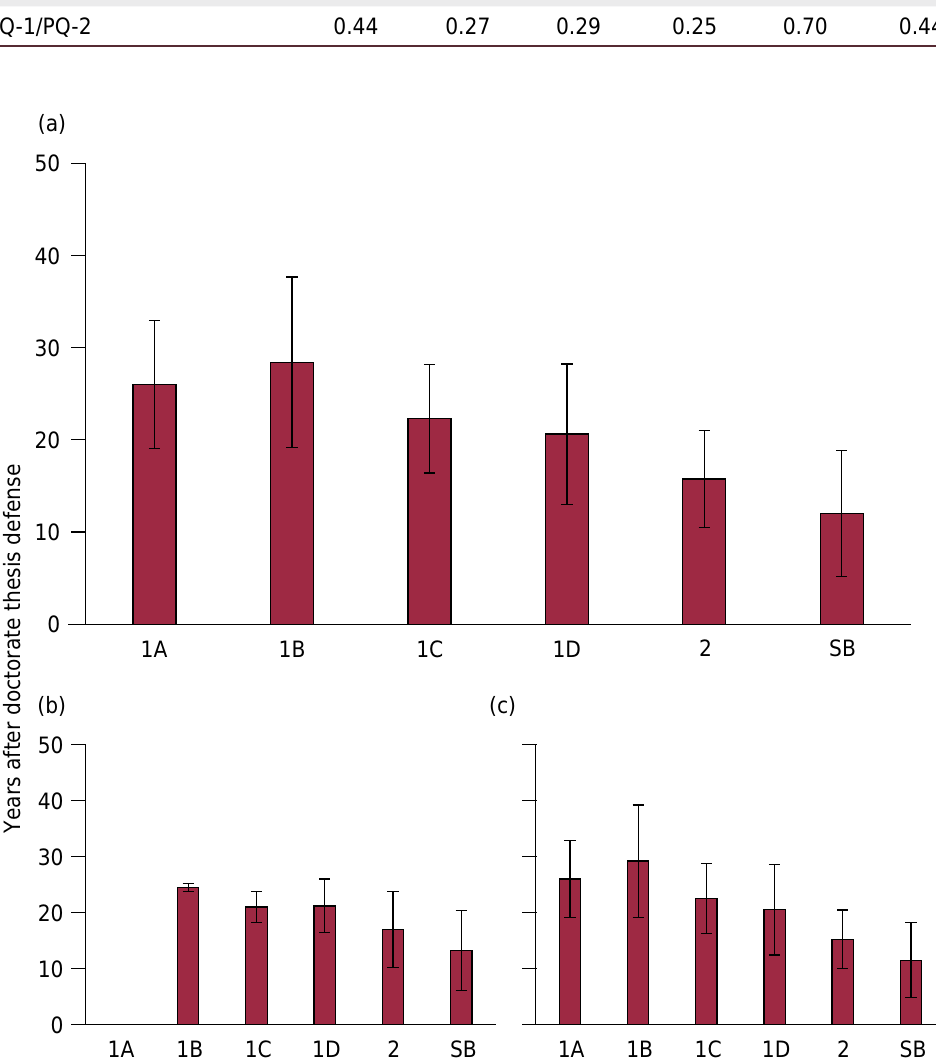
Figure 1. Scientific age (number of years after completion of the doctoral degree), by class of PQ fellowship and non-fellows (SB), for all researchers, regardless of gender (a) and by gender women (b) and men (c), in CNPq Call 2018. Vertical bars depict standard